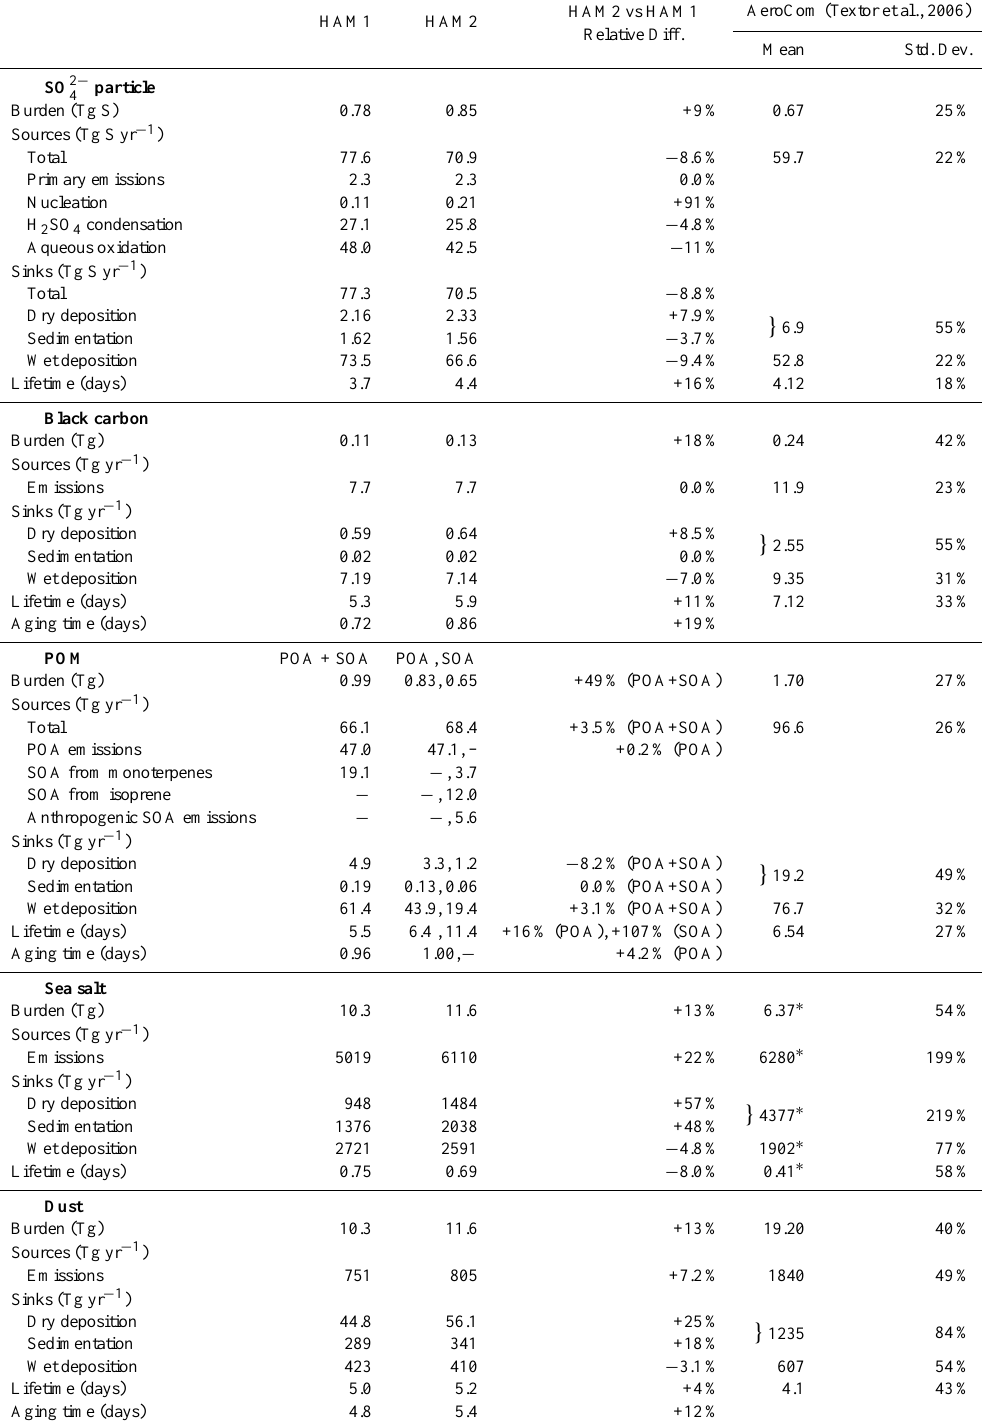
Table 8. Annual mean global mass budget of SU, BC, POM, SS and DU simulated by two version of the HAM model, and their relative differences. To put the numbers in perspective, the multi-model mean and standard deviation of the AeroCom intercomparison project (from Textor et al., 2006) are also listed. The standard deviations are given as percentages of the corresponding mean values. The AeroCom dry deposition listed here is the sum of dry deposition and sedimentation. For sea salt there was an outlier model that featured very high emissions. We therefore cite the multi-model median (indicated by asterisks) instead of mean for the sea salt budget.